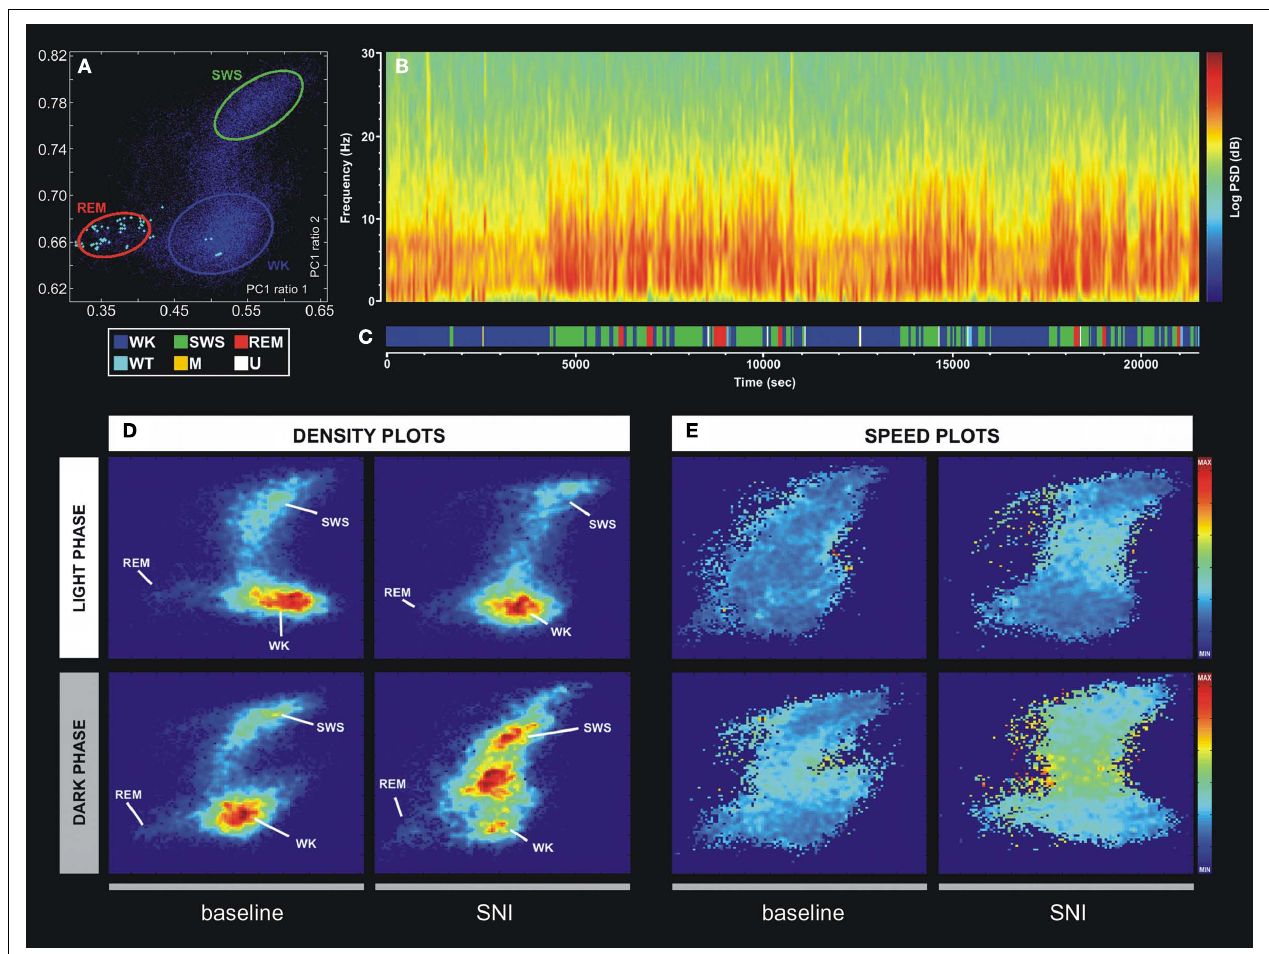
scatter plots [e.g., (A) ], showing the conserved cluster topography and the relative abundance of the various brain states. Scale from dark-blue (low-density) to red (high-density). (E) Speed plots representing the average of spontaneous trajectories within the two-dimensional StateMap. Stationarity (low speed) can be observed in the three main clusters (WK, SWS, and REM), whereas a maximum speed is reached during transitions from one clusters to another. After SNI lesion the velocity betweenWK and SWS state episodes increased, suggesting also an increase ofWK/SWS transitions during the neuropathic pain